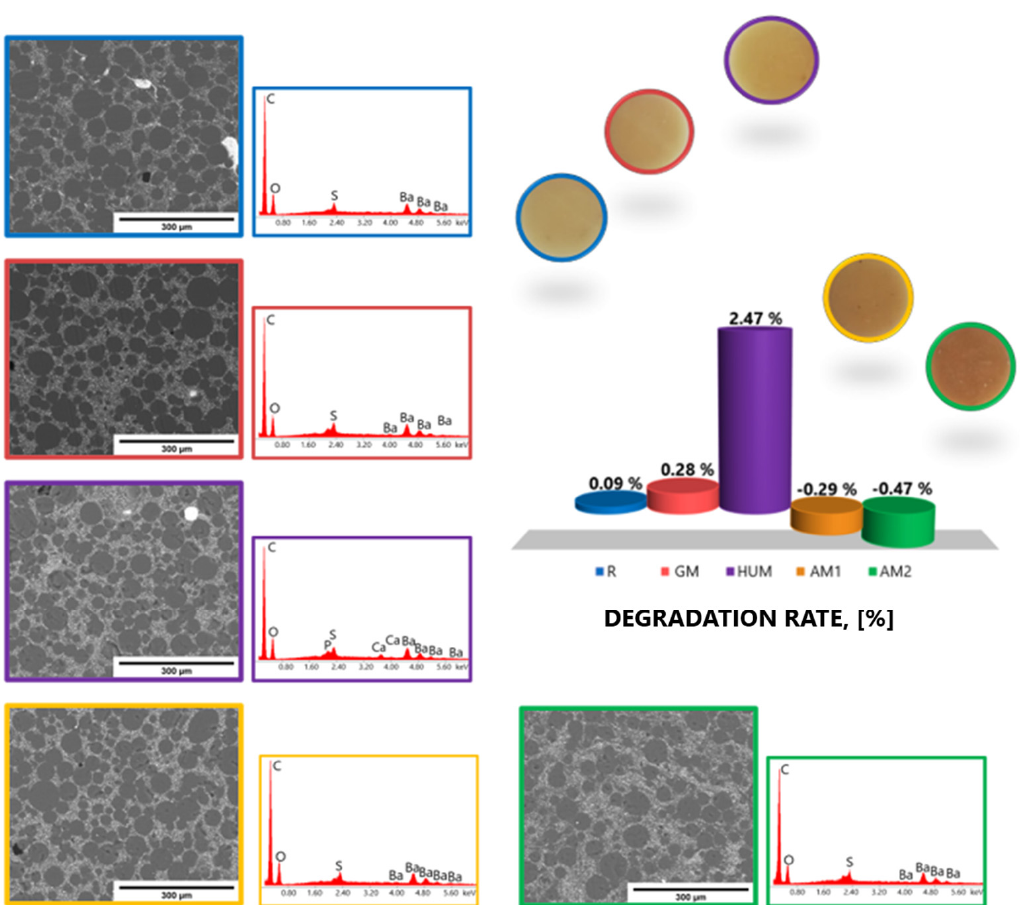
Figure 7. Morphological aspects revealed by SEM and elemental surface analysis by EDS of the experimental PMMA bone cements after 28 days in SBF.